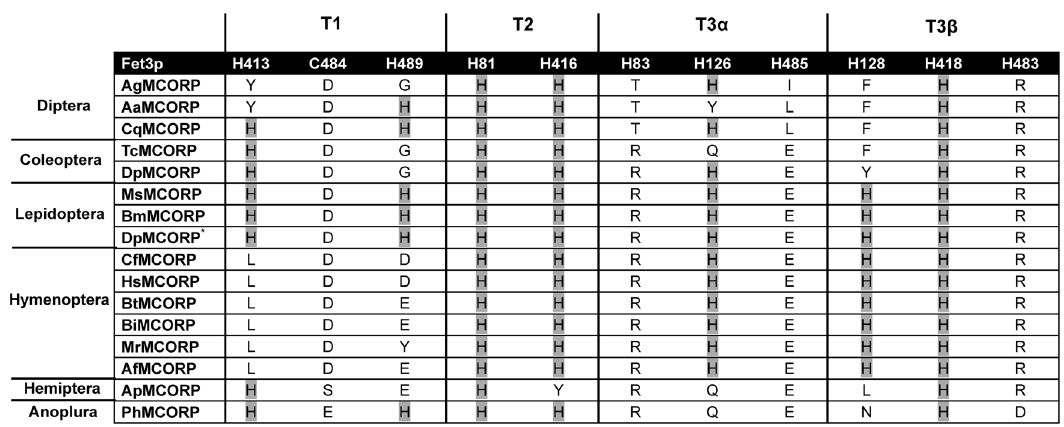
Figure 2. Comparison of copper-coordinating residues in Fet3p with the corresponding residues in MCORPs. Yeast multicopper ferroxidase, Fet3p, contains 10 histidines and 1 cysteine that coordinate to four coppers. T1 copper is coordinated with H413, H489 and C484, T2 copper is coordinated with H81 and H416, T3 a copper is coordinated with H128, H418 and H483, and T3 b copper is coordinated with H83, H126 and H485. Fet3p was aligned with each MCORP, and the corresponding residues in MCORPs are shown. Histidines conserved in MCORPs are highlighted in gray. Abbreviations used are the same as for Figure 1.